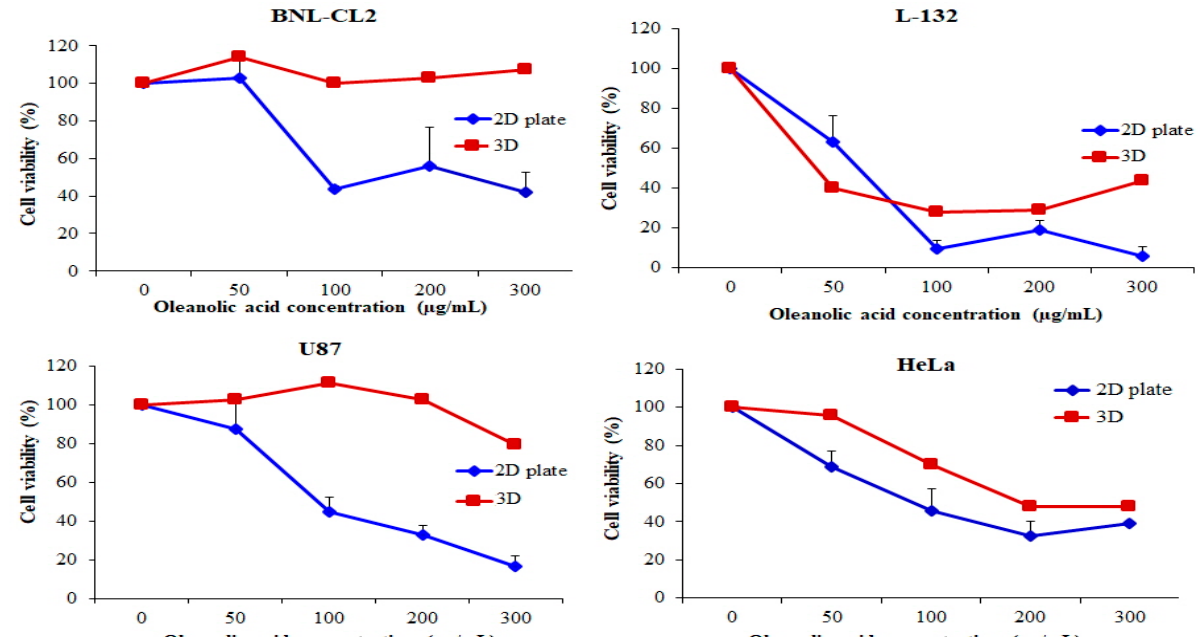
Figure 5. Cell viability evaluation of normal cell lines (BNL-CL2 and L-132) and cancer cell lines (U87 and HeLa) cultured in a two-dimensional (2D) plate and polydimethylsiloxane (PDMS) multi-channel cell chip, using the 3-(4,5-dimethylthiazol-2-yl)-2,5-diphenyl tetrazolium bromide (MTT) assay. The cells were cultured at 1 × 10 5 cells/mL and treated with oleanolic acid (OA; 50, 100, 200, 300 µg/mL) for 24 h. The relative cell viability was calculated as the percentage of untreated cells. The data are represented as mean ± SD, n = 3.